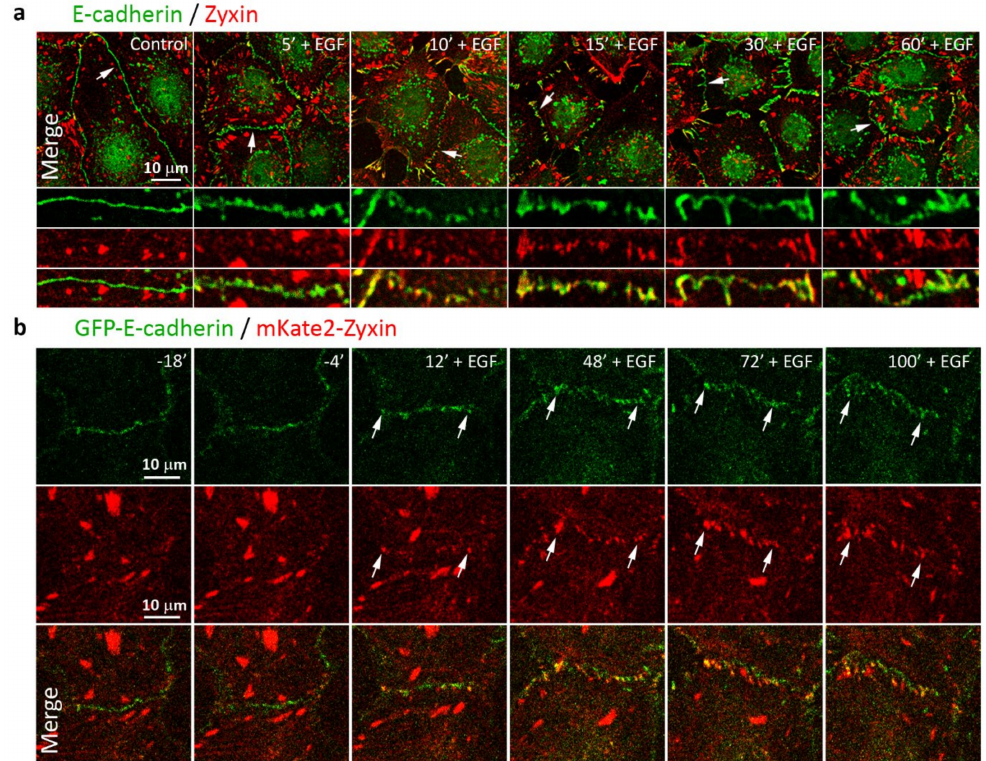
Figure 7. Accumulation of zyxin in AJs of IAR-20 cells treated with EGF. ( a ) Immunostaining of E-cadherin and zyxin. In control cells, zyxin does not accumulate in linear AJs. In EGF-treated cells, zyxin accumulates in punctate AJs. ( b ) IAR-20 cells stably expressing GFP-E-cadherin were transfected with mKate2-zyxin. Arrows indicate colocalization of zyxin with punctate AJs. Selected frames from Video